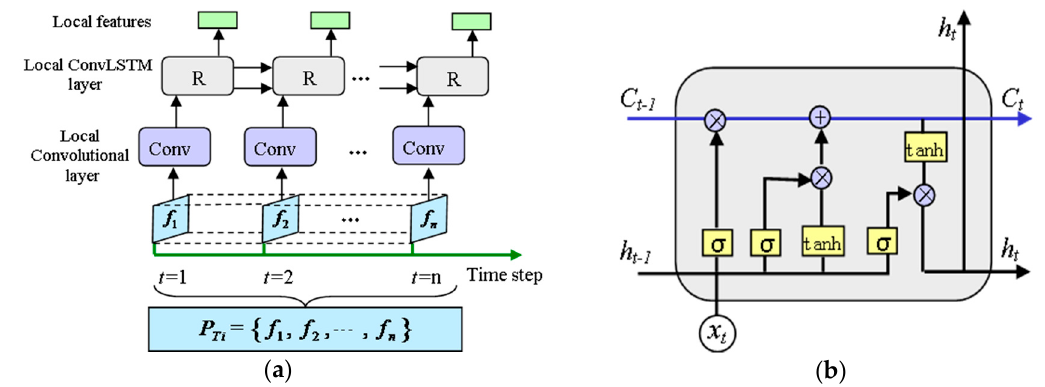
Figure 4. Local spatiotemporal feature extractor: ( a ) Structure of the local spatiotemporal feature extractor; ( b ) Diagram of the recurrent cell in ConvLSTM.